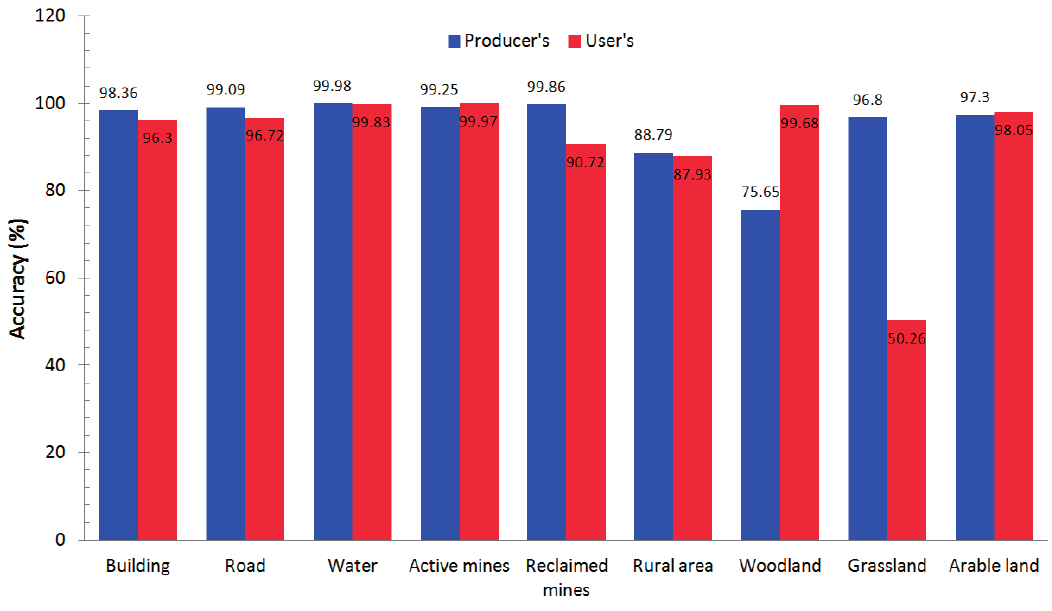
Figure 10. Accuracy assessment of the classification of land covers in the Jianshan